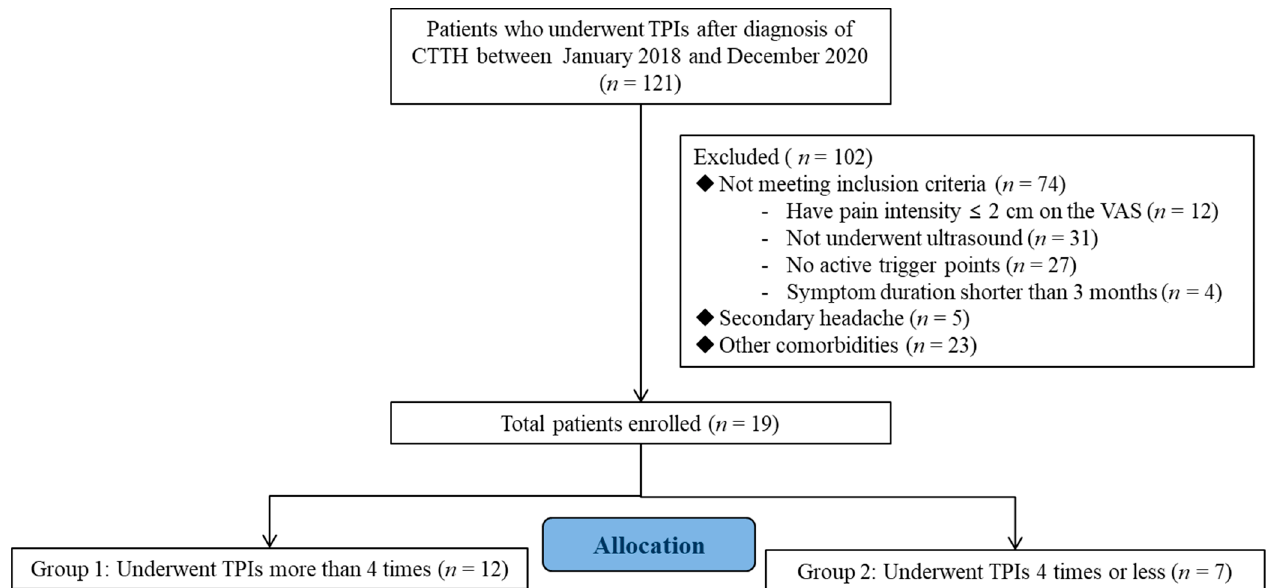
Figure 1. Flow diagram showing the study protocol. TPIs, trigger-point injections, CTTH, chronic tension-type headache.